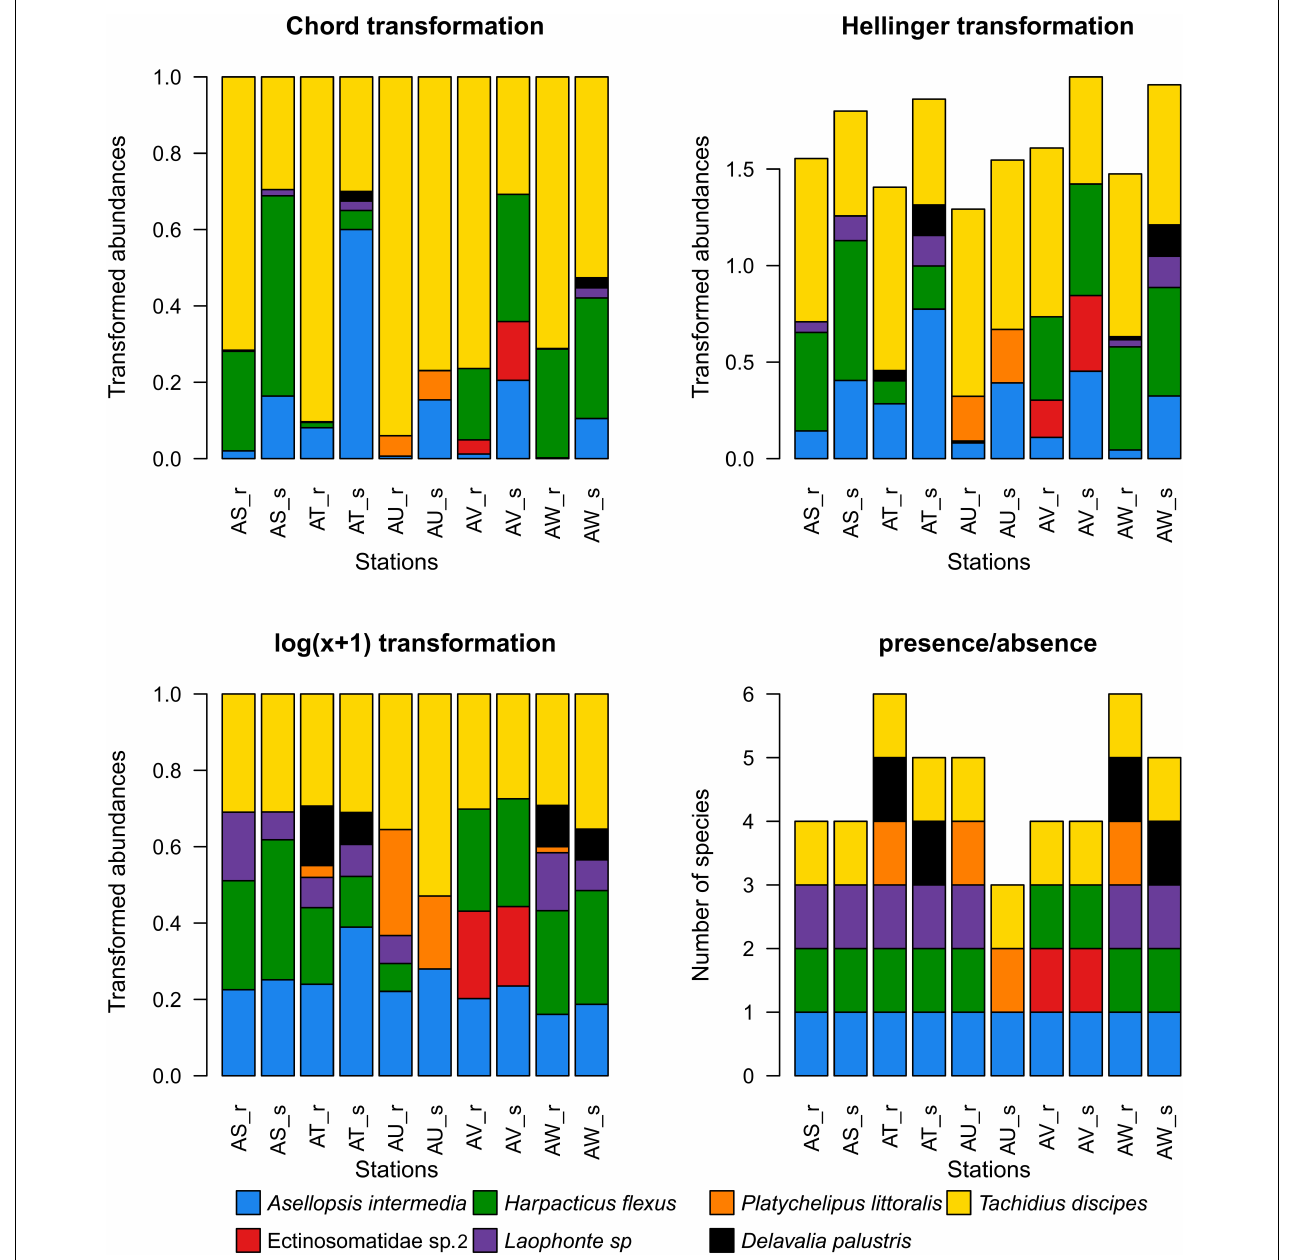
FIGURE 2 | Comparison of the number of reads (‘_r’) to the number of morphologically identified specimens/species (‘_s’) for all samples with four different data transformations. Of the four transformations, log(x + 1) transformation and working with presence/absence data reflect the relative abundance and the presence of species